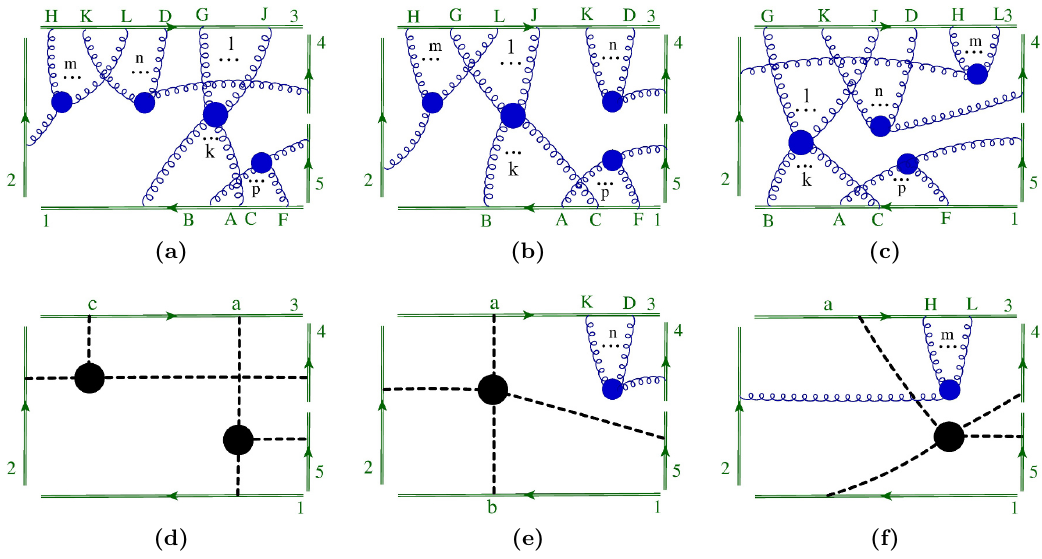
(1 , 1 , 1 , k + p, m + l + n ) 5